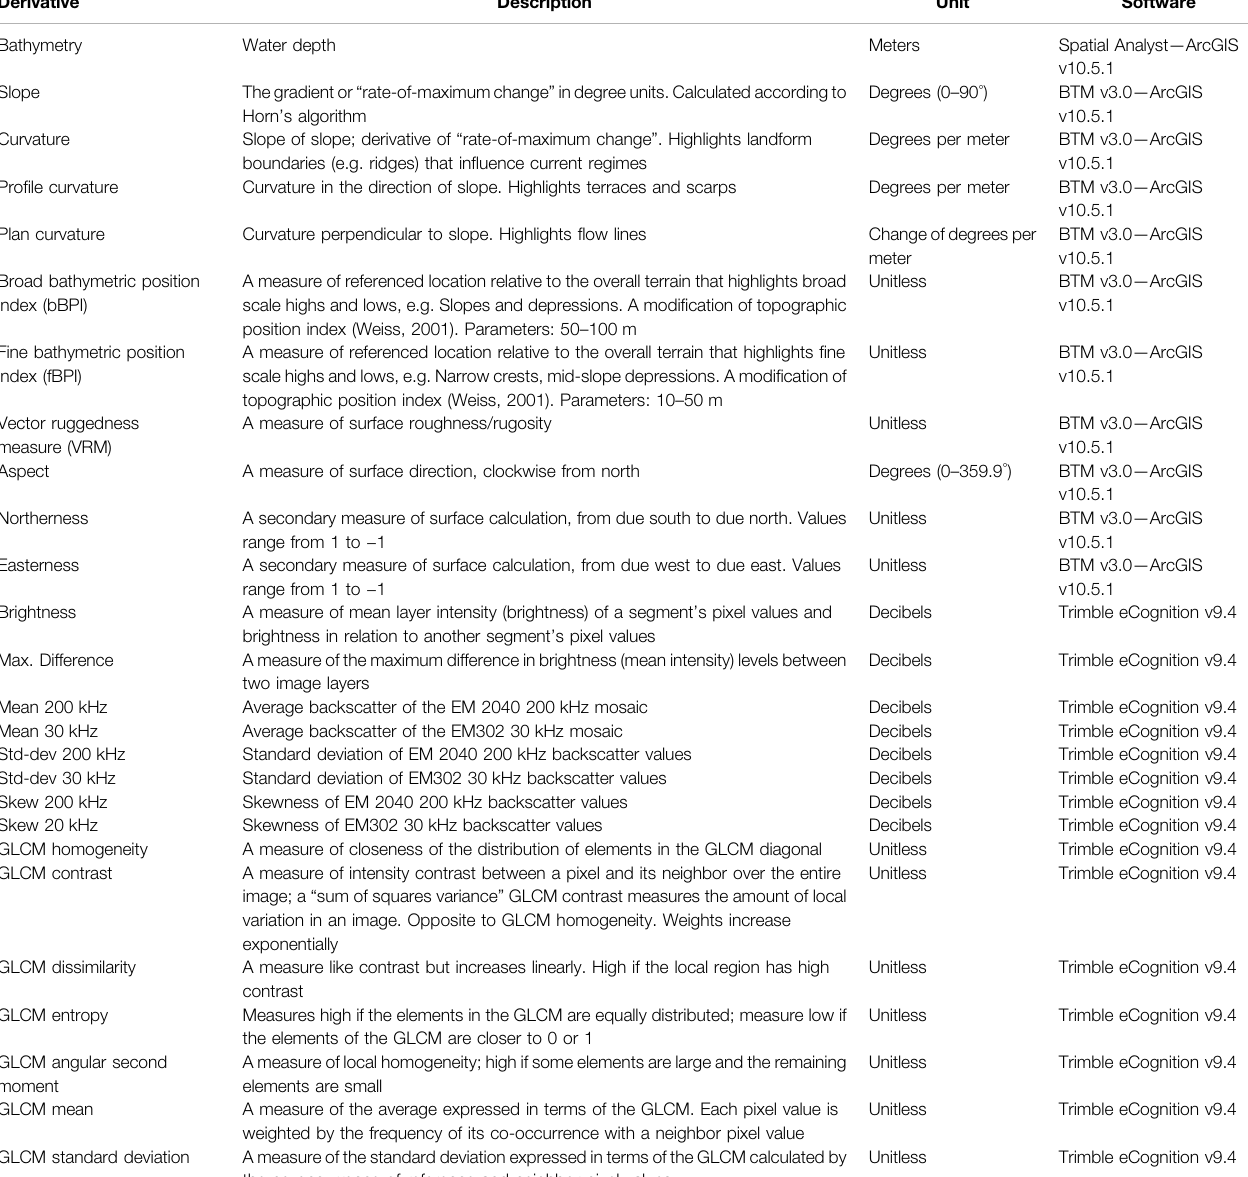
TABLE1| Bathymetricandbackscatterderivativesgeneratedformodelling.Allbathymetricderivativesarecalculatedusingamoving3 × 3window(Moore ’ sneighborhood).